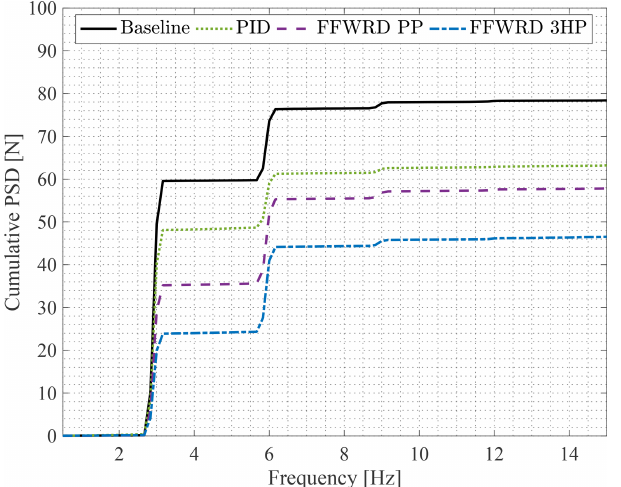
Figure 22. Cumulative power spectral density of the lift amplitude at the reduced frequency of k = 0 .